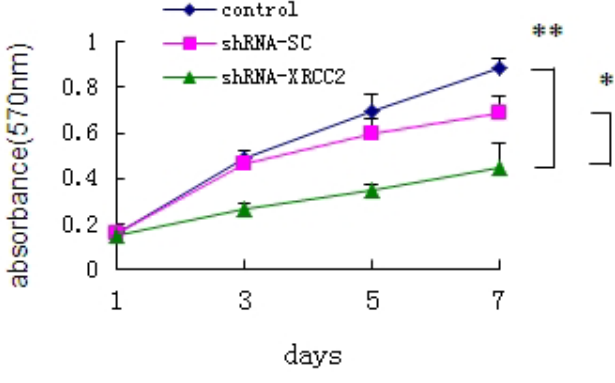
Figure 3. Knockdown of XRCC2 by shRNA inhibited cell growth of T84 cells. Cells were transfected with either shRNA-XRCC2 or shRNA-SC. The effect of XRCC2 suppression on cell growth in T84 cell line was examined by MTT assay. The values are presented as the mean ± SD ( n = 12). * p < 0.05, ** p < 0.01 compared with the control